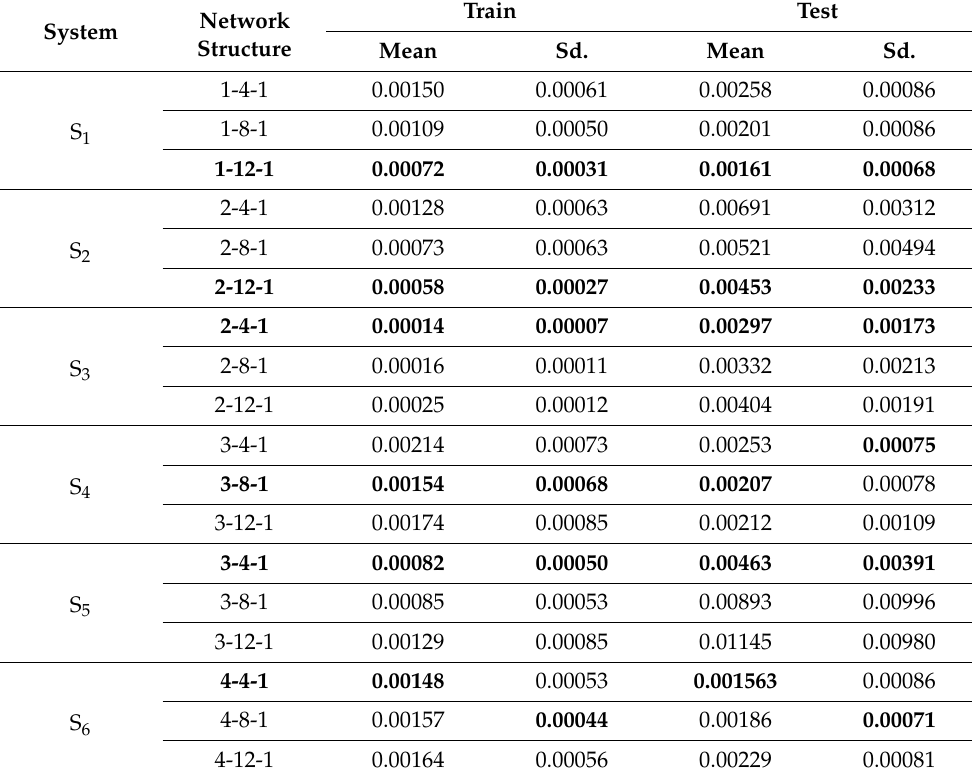
Table 6. The results obtained when using the HABCES algorithm for nonlinear static system